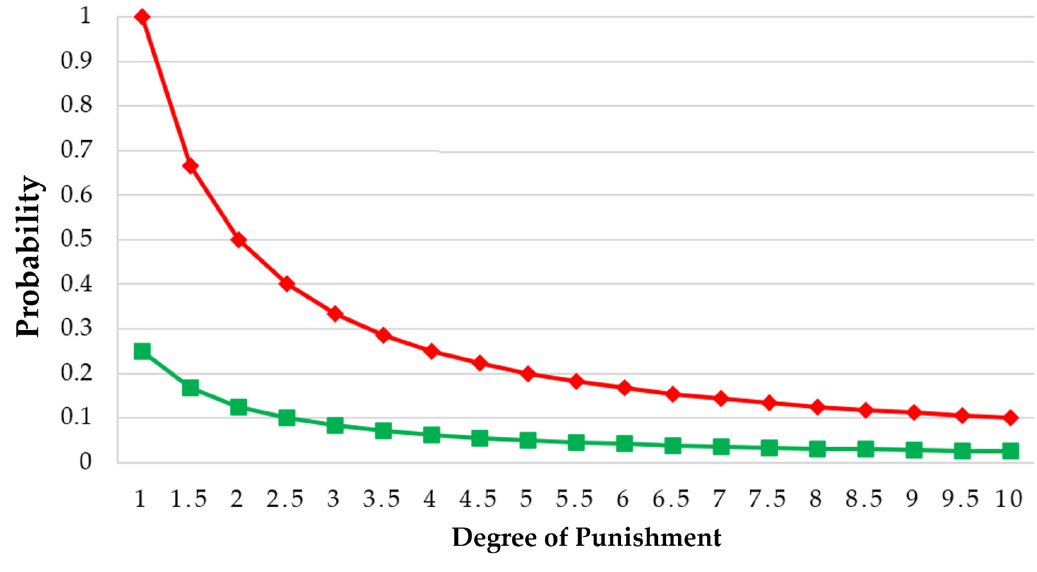
Figure 5. The relationship between the degree of punishment and the probabilities of SIU construction and government inspection.